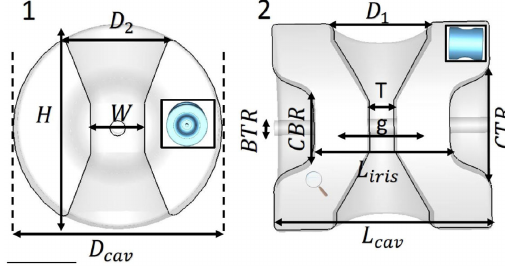
FIG. 18. Nomenclature used for the various geometric param- eters of the spoke